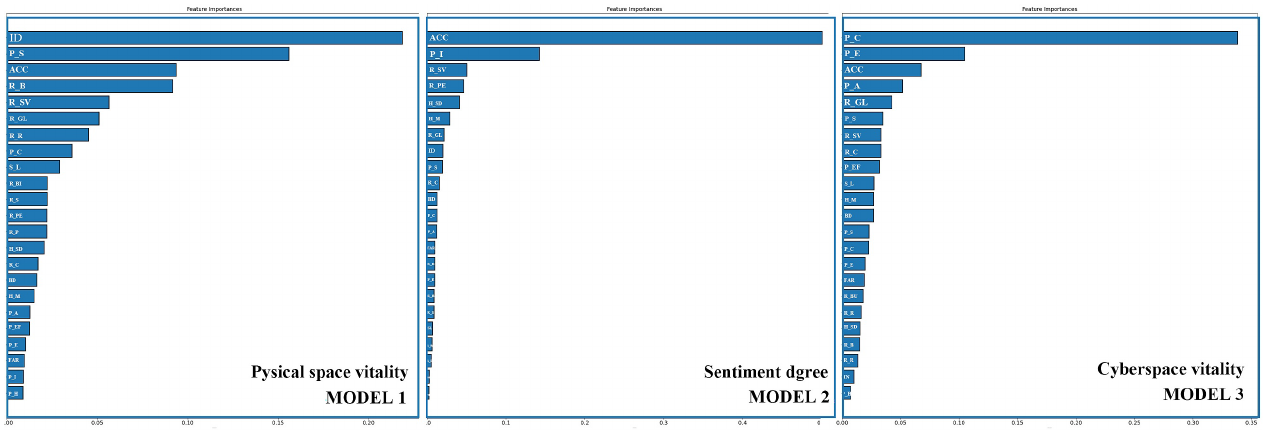
15 of 21 Table 4. Performance of 3 models (test set) . MODEL_NAME